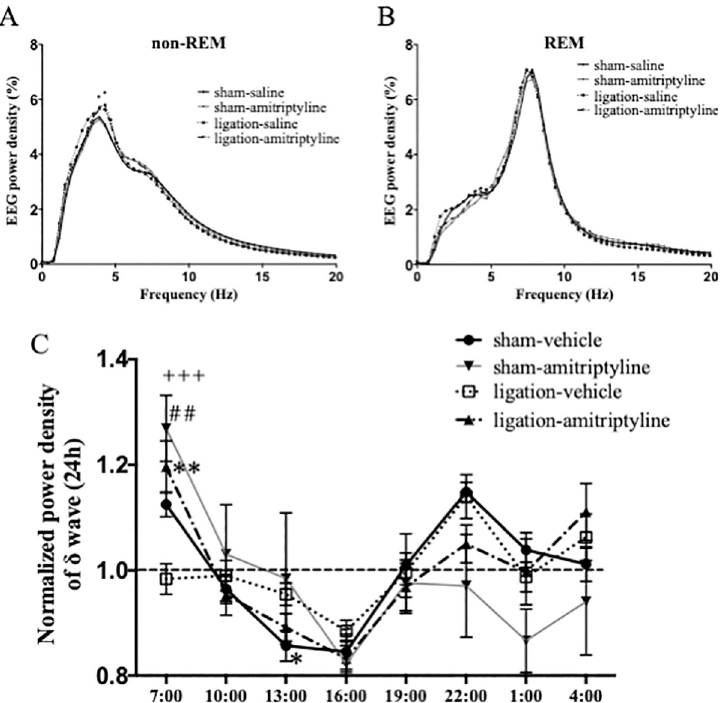
Fig 4. Amitriptyline improved quality of sleep in neuropathic pain model. Distribution of EEG power density in each frequency during non-REM and REM sleep. Data are expressed as means only. � P < 0.05 at 4.2 Hz and 4.7 Hz when comparing sham-vehicle and ligation-vehicle groups (A). Time changes of the normalized power density of δ wave were plotted every 3 hours in sham (n = 5–7) and nerve ligation (n = 7) mice. Data are expressed as means ± SEM (B) and are analyzed using two-way ANOVA followed by Bonferroni’s post hoc test and considered statistically significant at �� P < 0.01 when comparing sham-vehicle and ligation-vehicle groups, ## P < 0.01 when comparing ligation-vehicle and ligation amitriptyline group, and +++ P < 0.001 when comparing the sham-amitriptyline and ligation-vehicle groups.